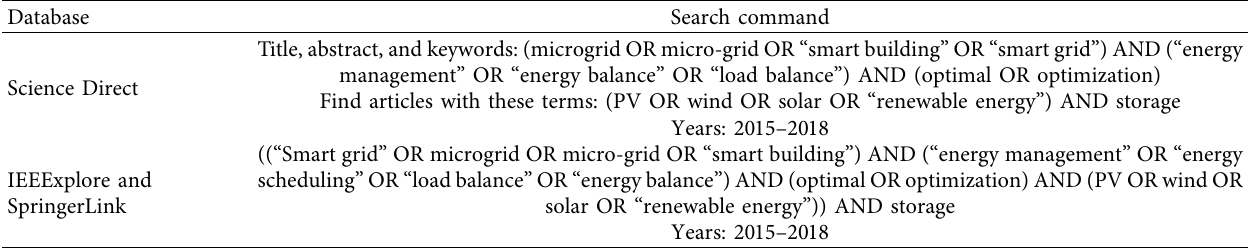
Table 2: Search commands. Title, abstract, and keywords: (microgrid OR micro-grid OR “smart building” OR “smart grid”) AND (“energy management” OR “energy balance” OR “load balance”) AND (optimal OR optimization) Find articles with these terms: (PV OR wind OR solar OR “renewable energy”) AND storage